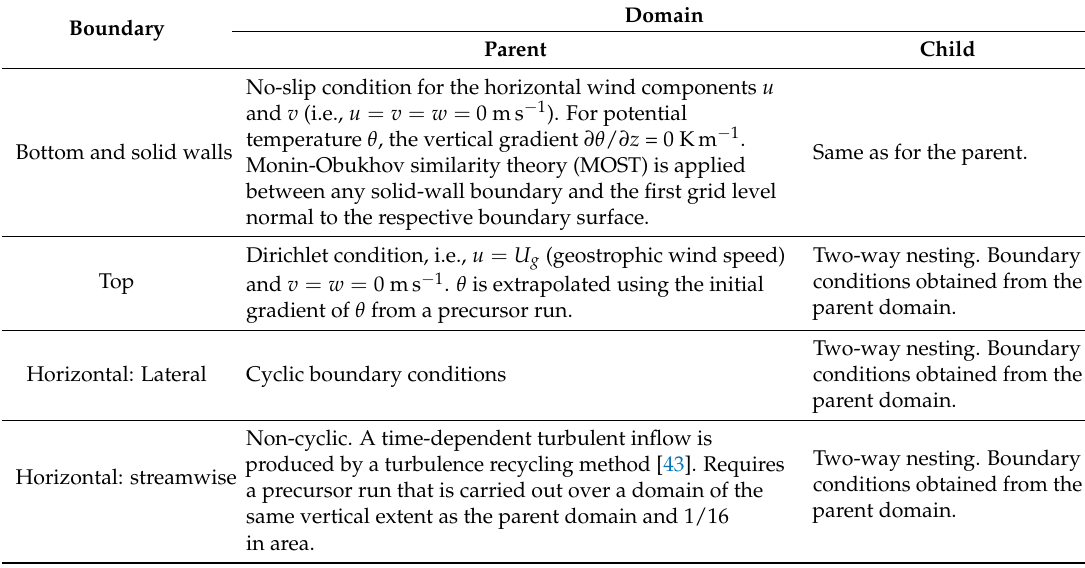
Table 1. The boundary conditions of the model runs. Details of the conditions can be found in Maronga et al.